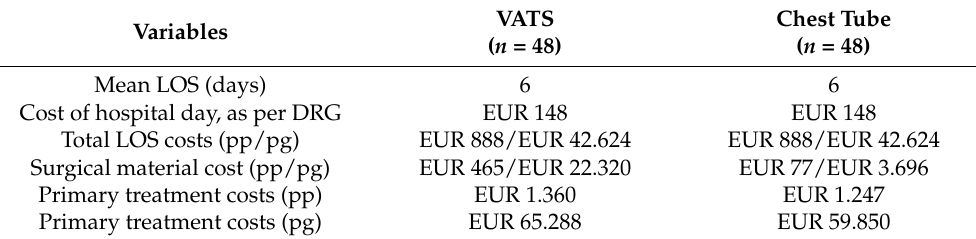
Table 4. Primary management